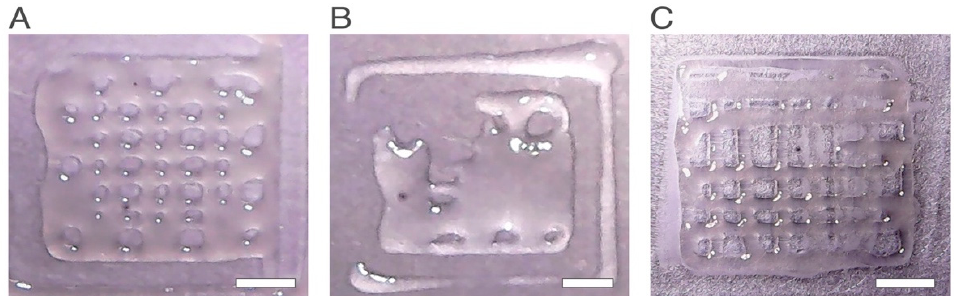
Figure 3. Printed scaffolds, for the experiments with the highest printability and number of pores. ( A ) Experiment number 1. High printability and high number of pores ( B ) Experiment number 7. Although the formed pores presented a relatively high printability score, very few pores were formed. ( C ) Experiment number 10. High printability and high number of pores result. The scale bars measure 5 mm.